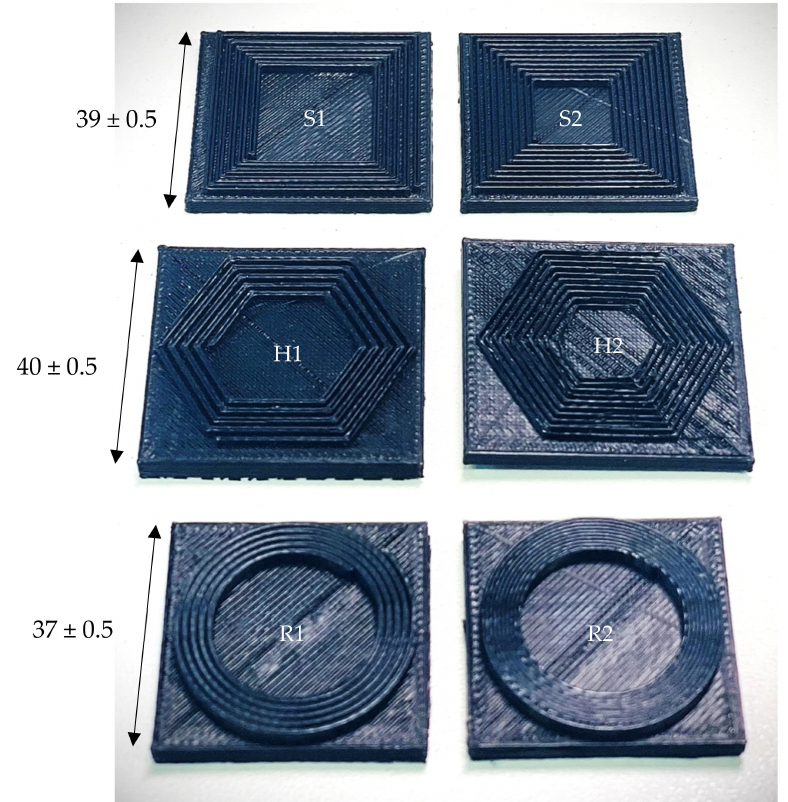
Figure 4. Typical trimmed-off 3D printed